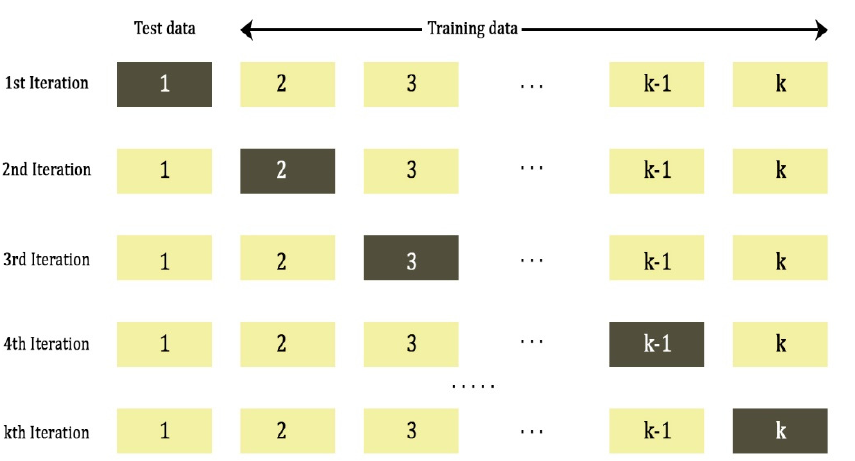
Figure 2. Schematic of k-fold cross